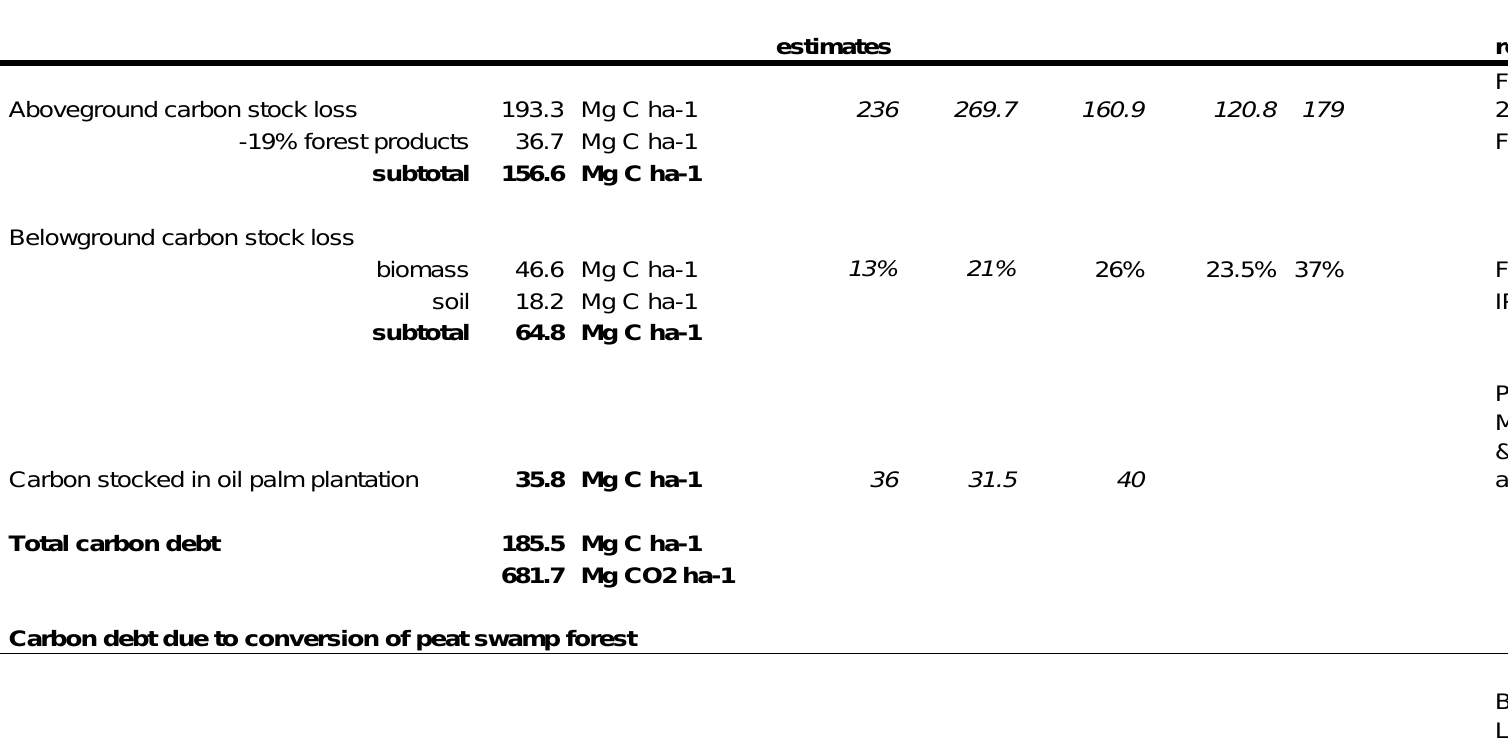
Table A2.3. Carbon debt calculation of the Boven Digoel, Papua, Indonesia case Carbon debt due to conversion of primary lowland tropical rainforest Papau,